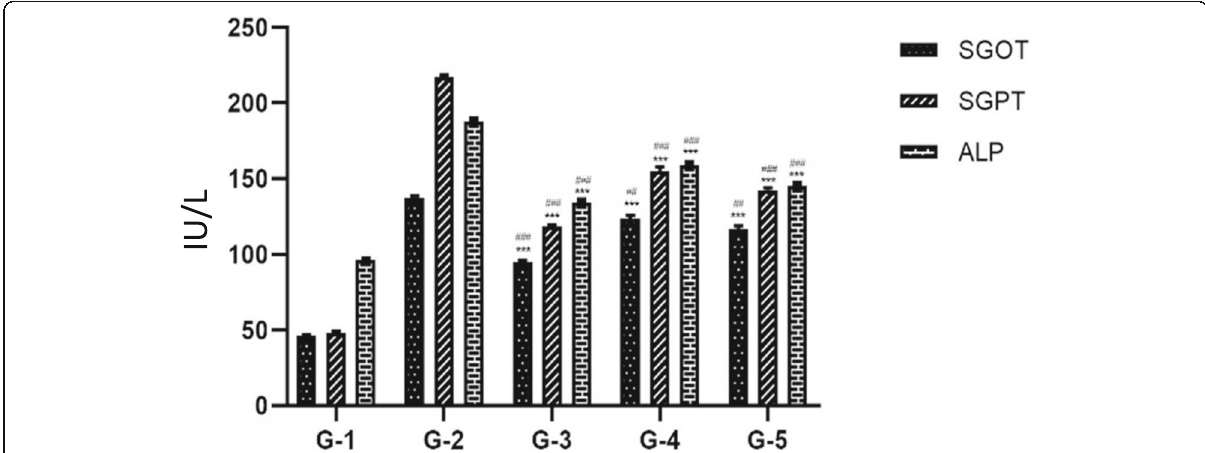
Fig. 2 Effect of GFME on enzyme SGOT, SGPT, ALP levels in blood serum of CCl 4 induced hepatotoxicity. Values are mean ±S.E.M. symbol represent statistical significance; *#p<0.02, **##p<0.001 and ***###p<0.0001.* indicates the comparison of G- 1 with G-3, G- 4, G-5; # indicates the comparison of G- 2 with G-3, G- 4, G-5.SGOT- Serum glutamyl oxaloacetate transaminase, SGPT- Serum glutamyl pyruvate transaminase, ALP-Alkaline phosphatase. G1- normal control, G2-negative control, G3- standard, G4- GFME (200mg), G5- GFME